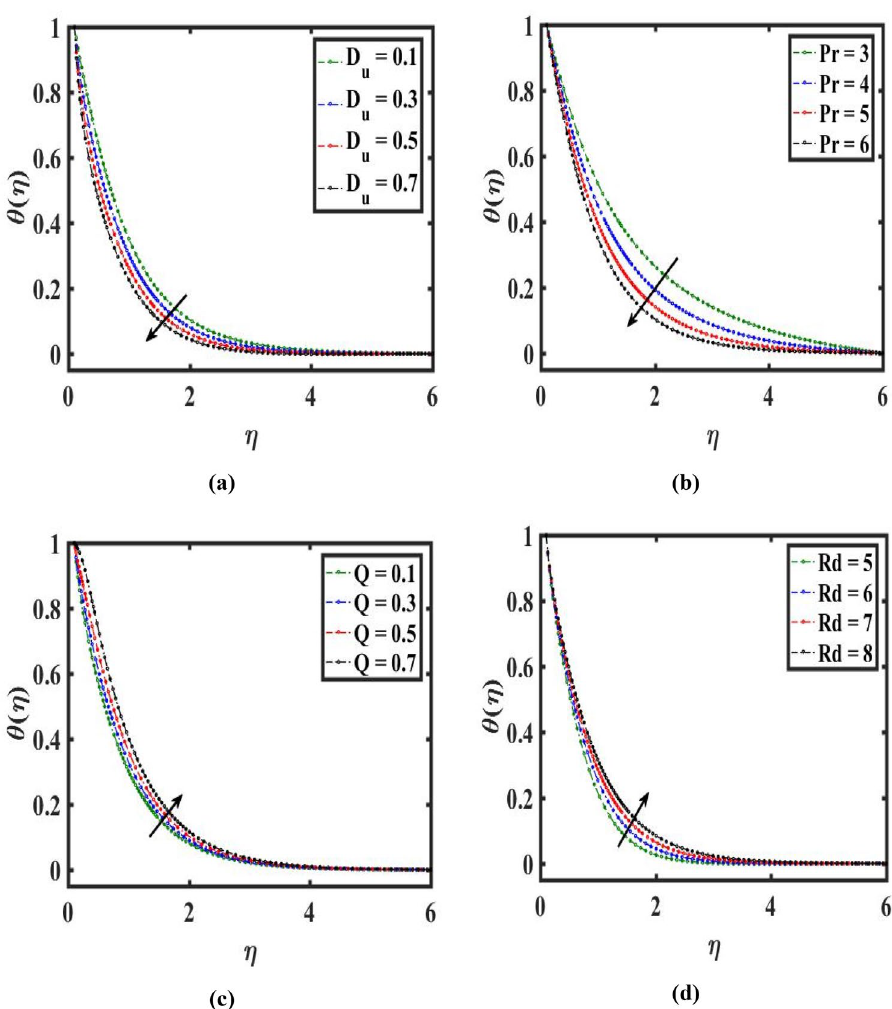
Figure 5. Effect of Dufour number D u , Prandtl number Pr , heat generation Q and radiation Rd on temperature θ(η)